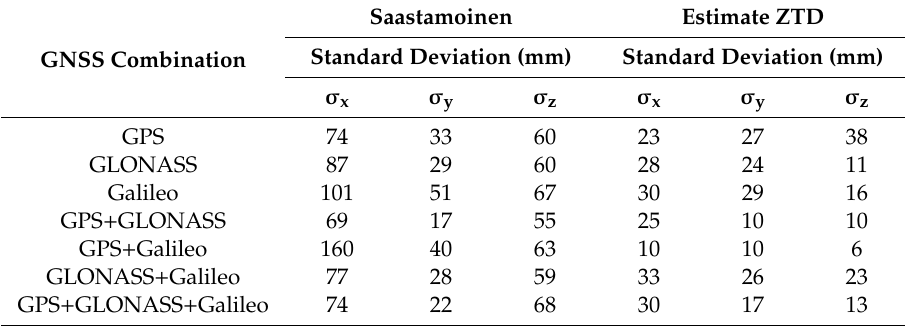
Table 3. Standard deviation of the considered GNSS combinations with Saastamoinen and Estimate ZTD tropospheric models (outlier rejections).